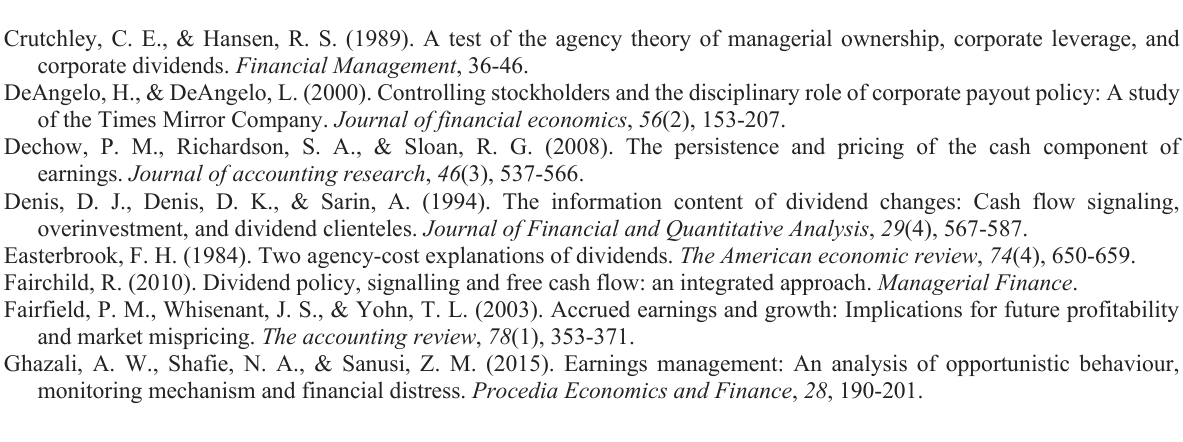
Source: Output WarpPLS